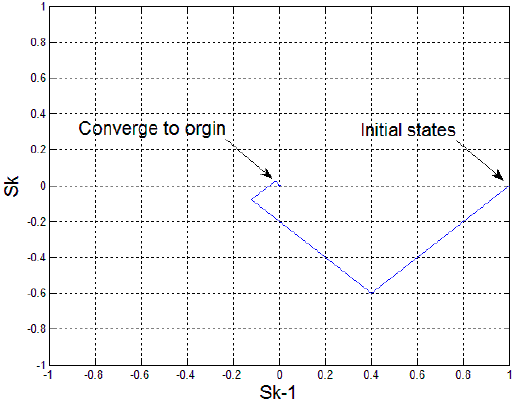
Figure 6. Proof of the convergence of the two-dimension control. The initial condition s k − 1 = 1, s k = 0. The control frequency = 10